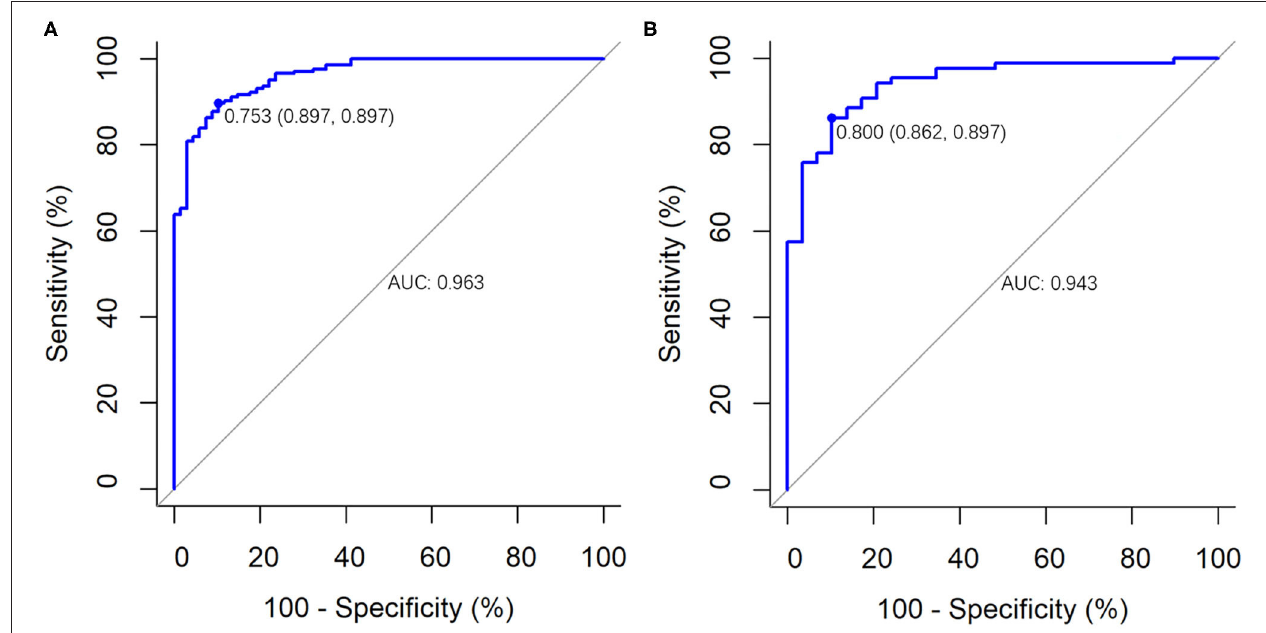
FIGURE 4 | The performance of the LASSO logistic regression model for differentiating COVID-19 pneumonia from influenza A (H1N1) pneumonia. It was presented by ROC curves in (A) the primary cohort (AUC, 0.963; 95% CI: 0.942–0.984) and (B) the validation cohort (AUC, 0.943; 95% CI: